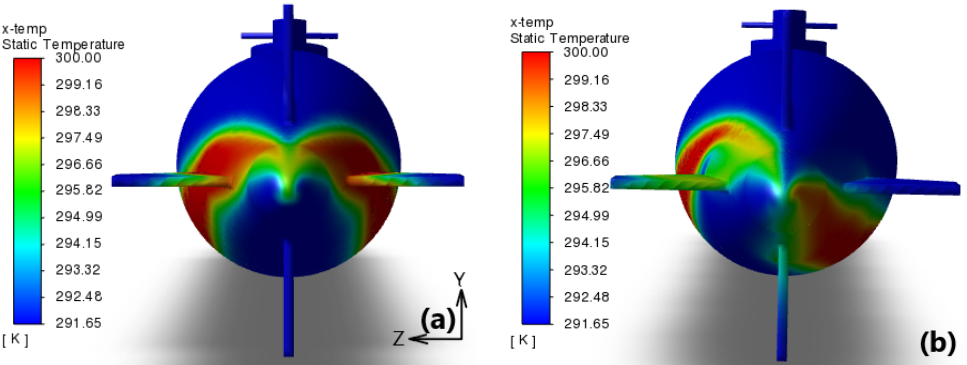
Figure 12. Motion track of cooling water of underwater vehicle under different motion states: ( a ) Direct flight; ( b ) Rotary motion.